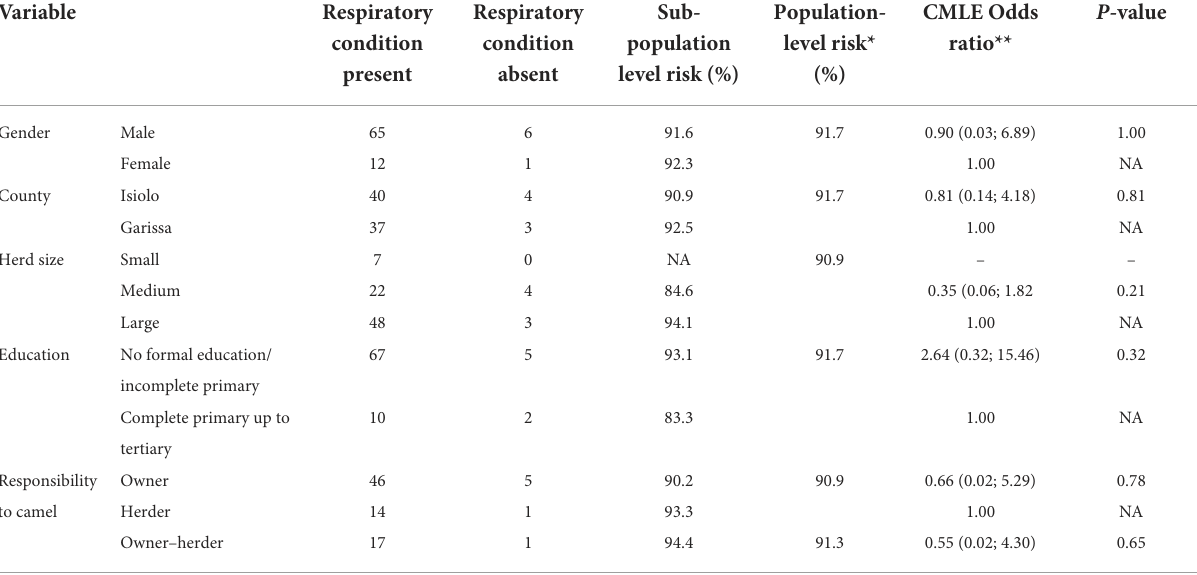
TABLE 2 Risk and odds-based estimates of respiratory illnesses and conditions in Kenya camels. Variable